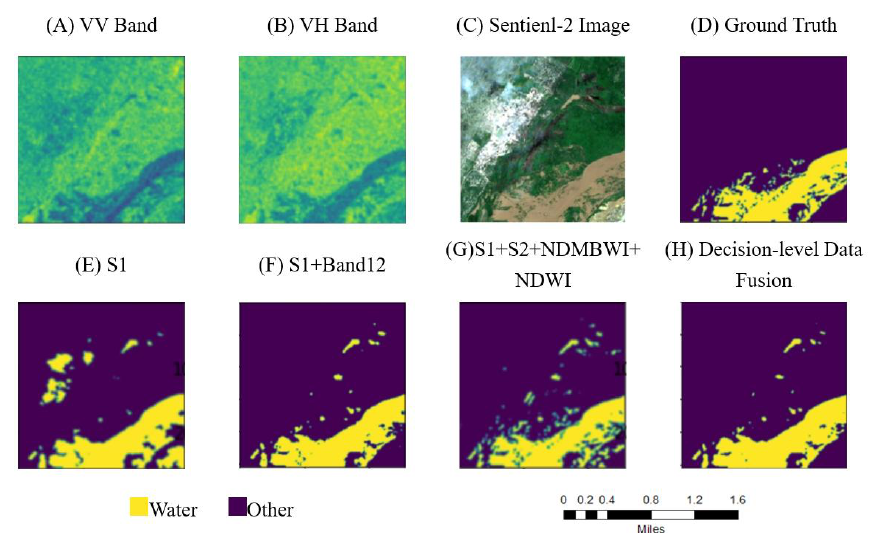
Figure 5 . Results of data fusion in cloud-free area.